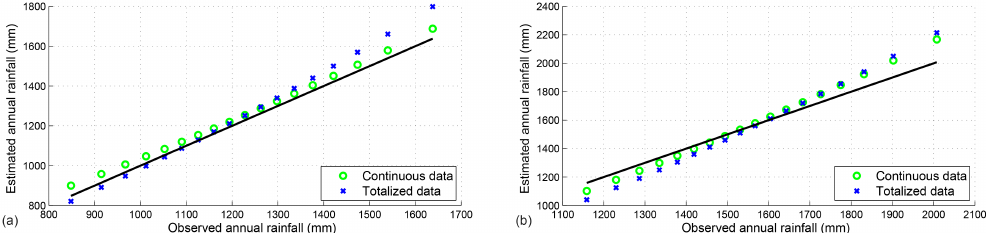
Figure 11. Effects of data resolution on the distributions obtained with derived distributions for Concepción (a) and Lugano (b) . The diagonal black line represents a perfect agreement.